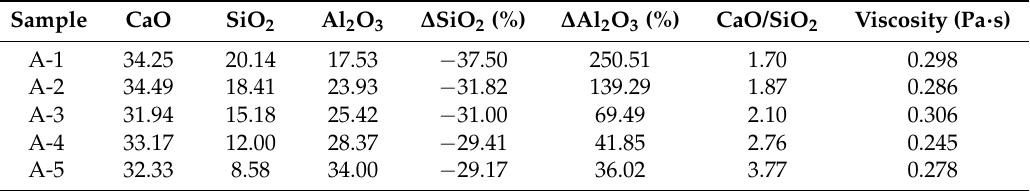
Table 5. Compositions of mold slag with different Al 2 O 3 /SiO 2 ratios after steel/slag reaction (wt.%).